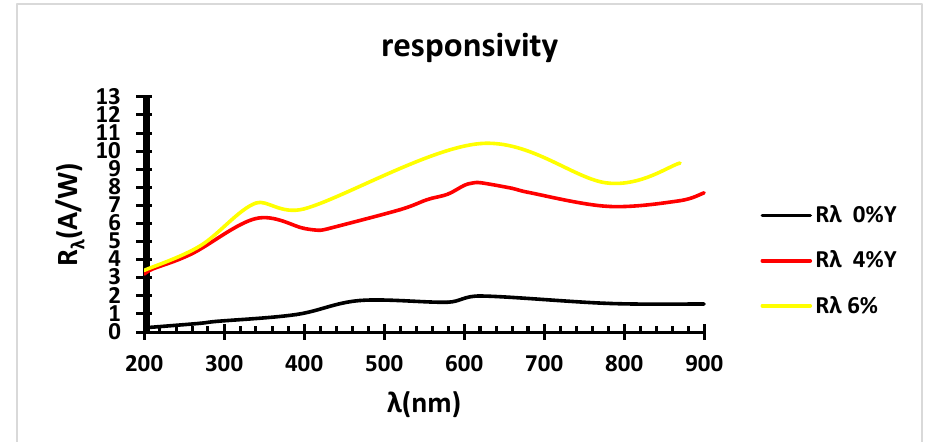
of undoped and doped Co λ